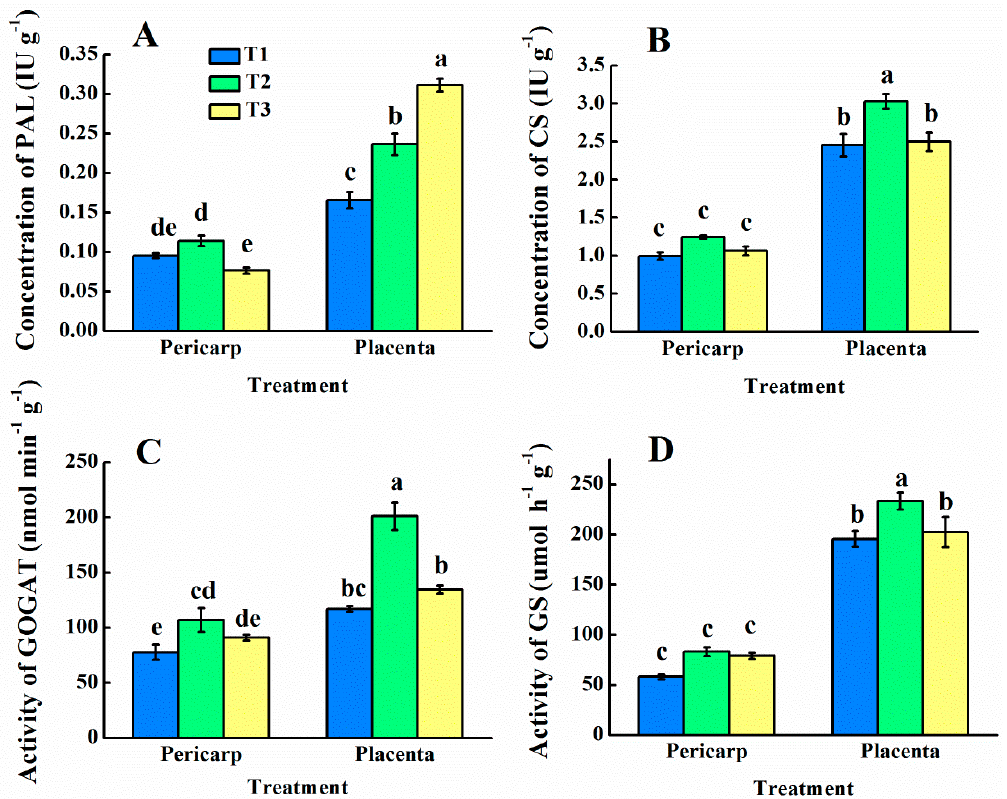
Figure 6. Activities of phenylalanine ammonia-lyase (PAL) ( A ), capsaicinoid synthetase (CS) ( B ), glutamate synthase (GOGAT) ( C ), and glutamine synthetase (GS), and ( D ) enzymes in pepper pericarp and placenta at different NH 4+ :NO 3 − ratios. Vertical bars represent the mean ± SE ( n = 3) and different letters denote significant differences ( p < 0.05). T1, NH 4+ :NO 3 − = 0:100; T2, NH 4+ :NO 3 − = 25:75; T3, NH 4+ :NO 3 − = 50:50.